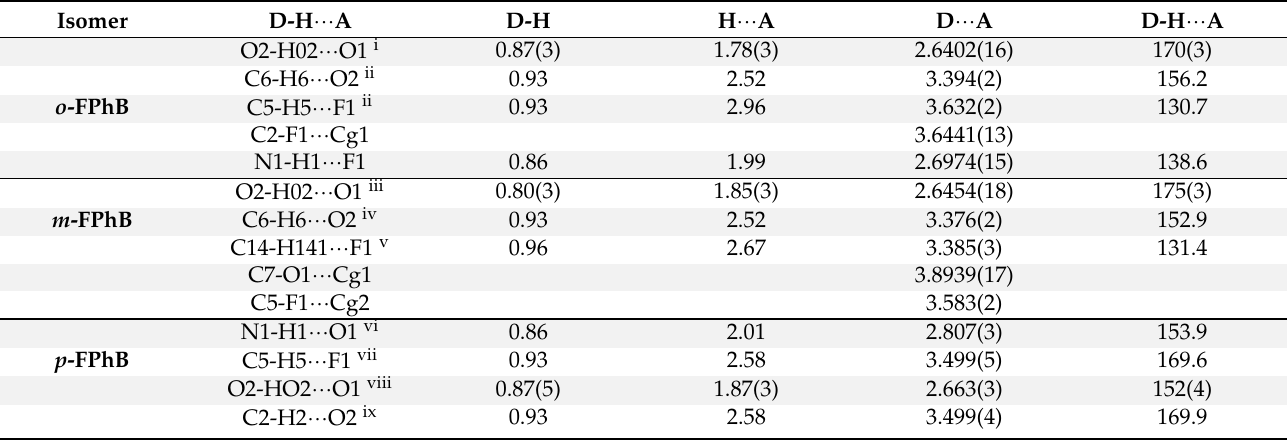
Figure 1. Ortep diagram of the o -FPhB , m -FPhB , and p -FPhB . Non-hydrogen atoms are drawn as 50% probability ellipsoids and hydrogen atoms as small spheres of arbitrary size. Table 1. Hydrogen-bond geometry (Å, o